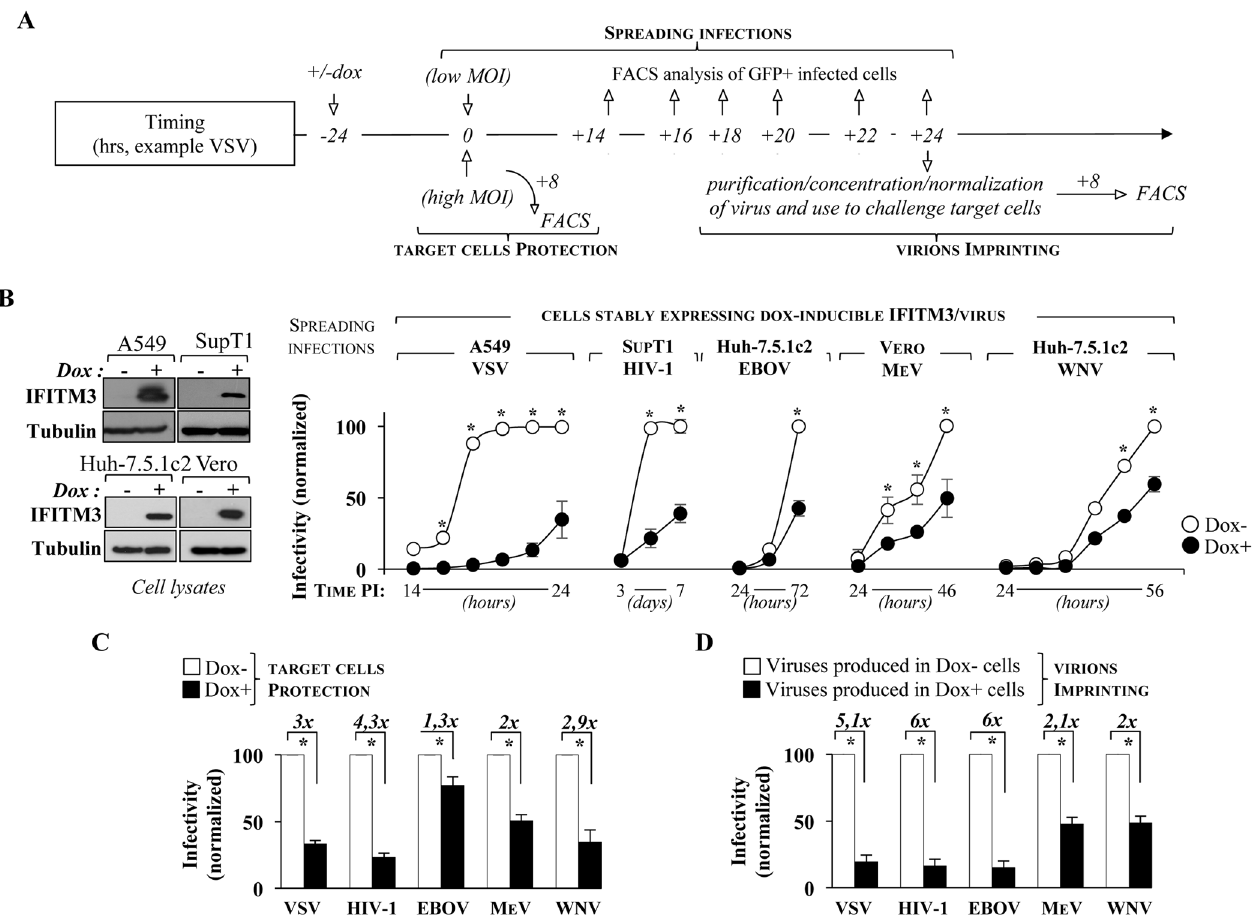
Fig 7. The overall negative effectsplayed by IFITM3 during viral spread are the result of two concomitant antiviral mechanisms, acting in the protection of target cells as well as in the production of virion particles of decreasedinfectivity. A) Scheme of the experimental approachused here. For simplicity, a detailedtime analysisis shown only for VSV. B) Cells stably expressing a dox-inducibleIFITM3 were treated or not with doxycycline (for twenty-four hours) and then challengedwith the indicatedviruses (MOIs comprised between 0.01 and 0.2 dependingon the virus). The panels displaya typical inductionobtained upon twenty-four hours stimulationwith concentrations of doxycycline comprised between1.5 and 10 μ g/ml dependingon the cell type. The extent of viral spreadingthrough the culture was assessed over time (by FACS since most viruses coded GFP and by exo-RT in the case of HIV-1 that did not). C) The same cells were used to measurethe degreeof protection offered by IFITM3 towards WT virus infection. To approximate a single round of infection, infectionswere carried out with highviral inputs (MOIs comprised between0.1 and 0.5) and the proportionof infected cells was determined shortly after viral challenge by FACS. In the case of HIV-1, single round- competent viruses codingGFP were used to allow flow cytometry-based analysisof the percentage of infection. D) Virion particlesretrieved from infected cell cultures expressingor not IFITM3 at the latest time points were purifiedand then normalized for protein or genomecontent. The infectivity of normalizedvirions producedin infected cell cultures expressingor not IFITM3 was then assessedas describedaboveon HeLaP4 (VSV and HIV-1), Vero (EBOV and MeV) or Huh-7.5.1c2 cells (WNV). The graph present averages and SEM of 3 independentexperiments. * , p (cid:20) 0.05after a Student t test.